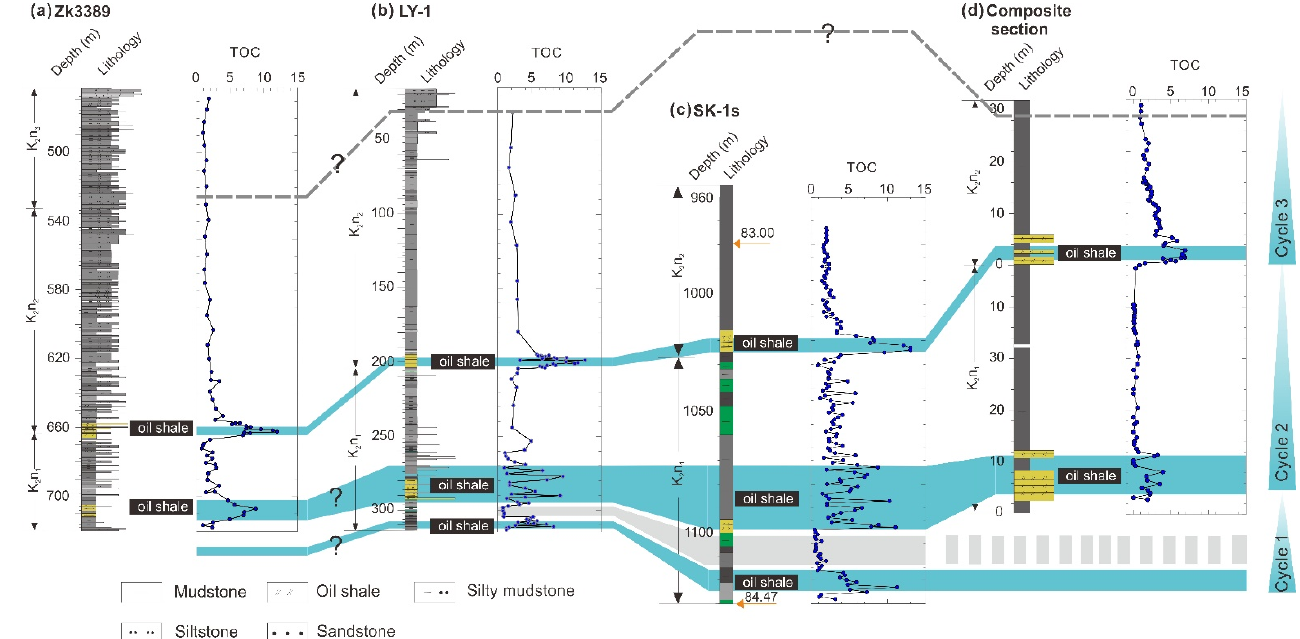
Figure 2. TOC chemostratigraphic records from the Nenjiang Formation and stratigraphic correlation with four sets of TOC records based on the TOC variation patterns. ( a ) The TOC curve from Zk3389 well [8]. ( b ) The TOC records from the LY-1 drilling core [18]. ( c ) The new TOC records from SK-1s. ( d ) The TOC records compiled from the composite section